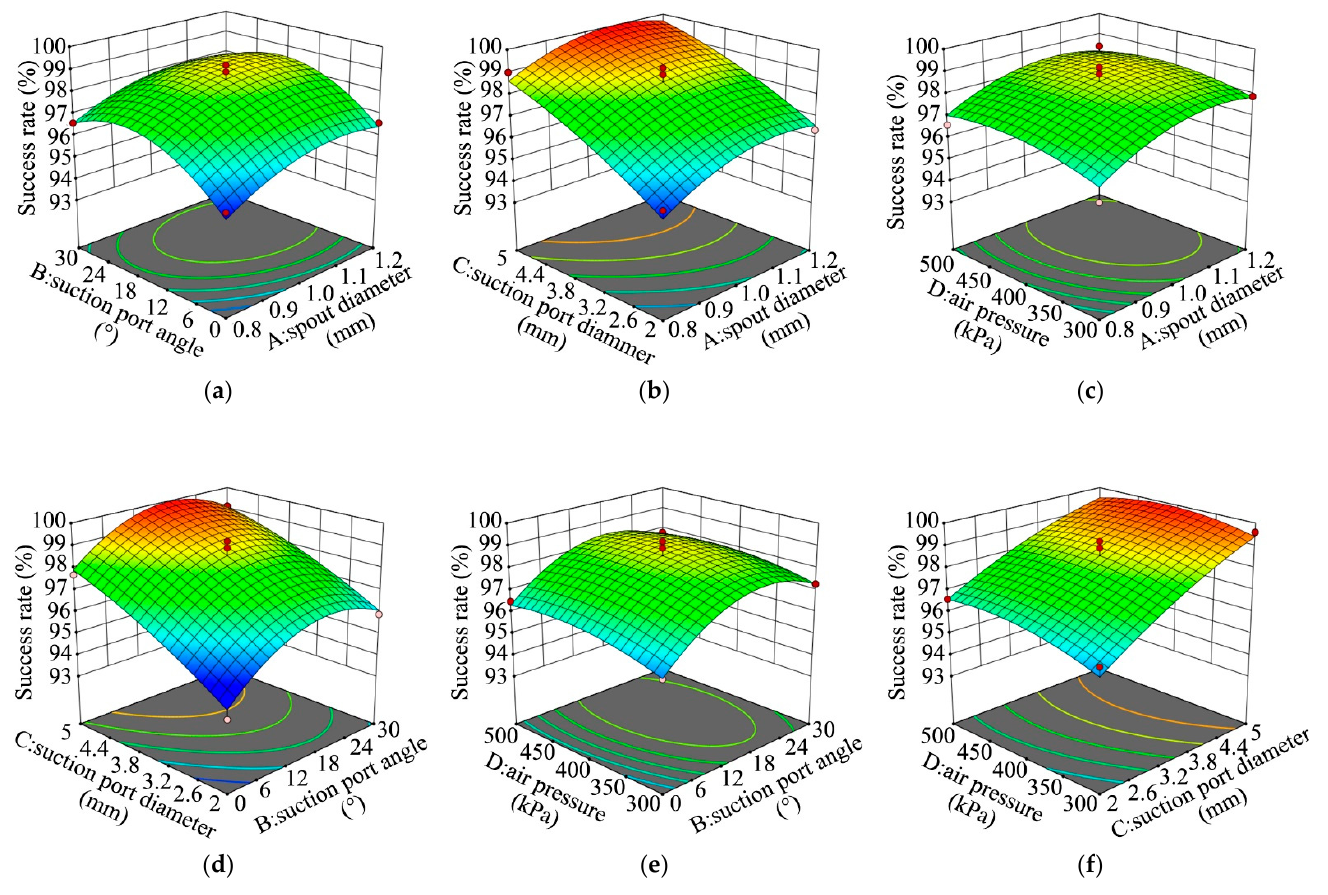
Figure 22. Response surfaces of test factors influence on success rate of seed sucking. ( a ) Y 1 ( X 1 , X 2 , 0, 0); ( b ) Y 1 ( X 1 , 0, X 3 , 0); ( c ) Y 1 ( X 1 , 0, 0, X 4 ); ( d ) Y 1 (0, X 2 , X 3 , 0); ( e ) Y 1 (0, X 2 , 0, X 4 ); ( f ) Y 1 (0, 0, X 3 , X 4 ).